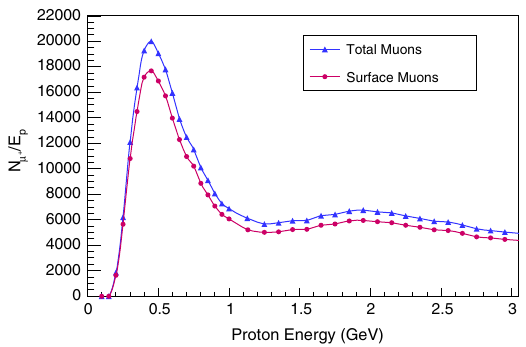
FIG. 13. Normalization to the number of protons interacting in the